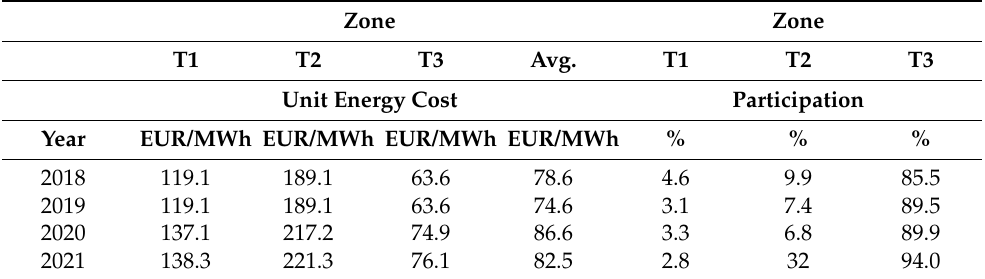
Table 3. Calculated 20-year average price of energy for 3 variants of price increase.